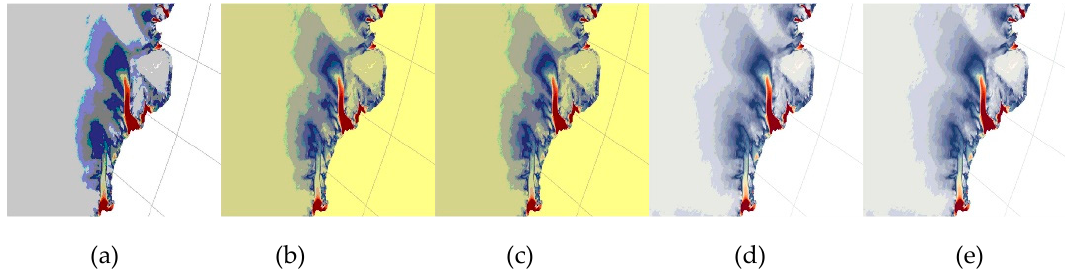
Figure 14. The segmented results of Satellite image7. ( a ) WOA; ( b ) FPA; ( c ) PSO; ( d ) BA; and ( e ) HSOA.